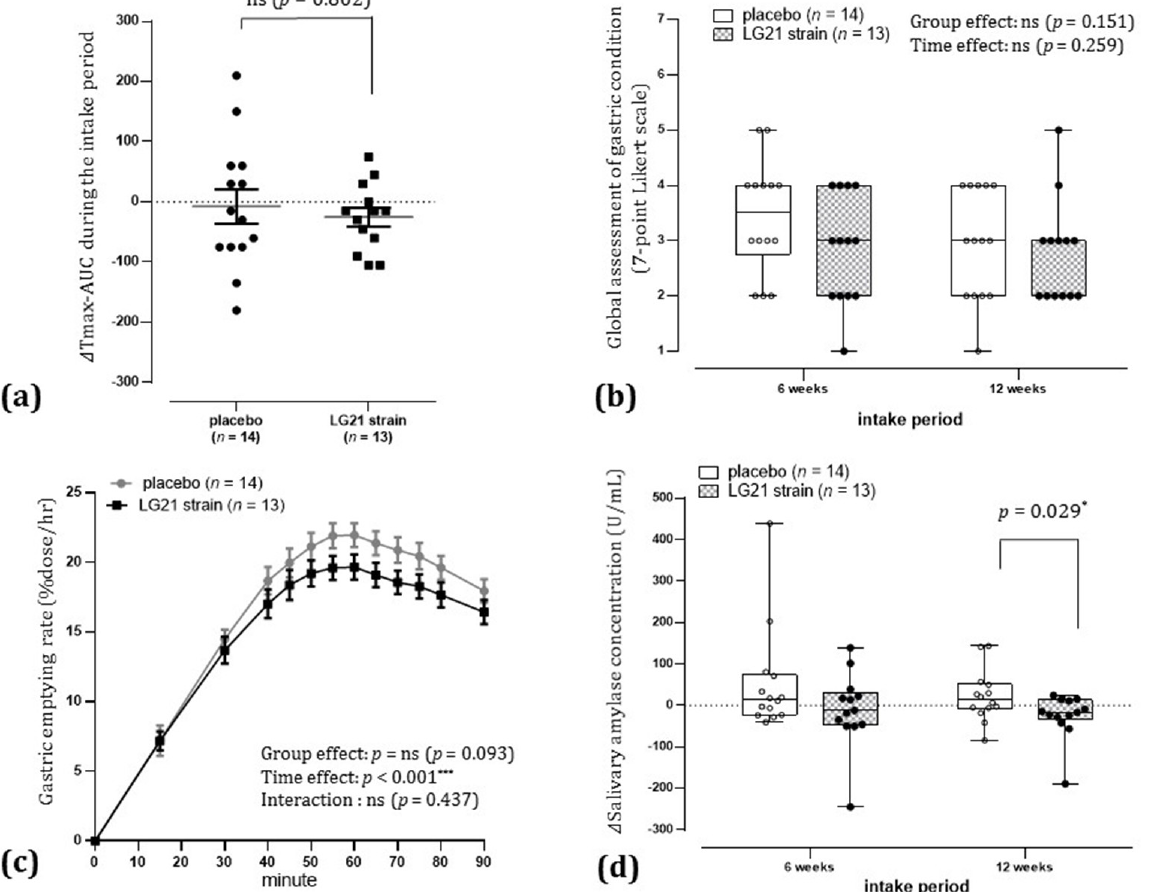
Figure 3. Effects of continuous intake of the LG21 strain in the per-protocol population. ( a ) ∆ Tmax-AUC during the intake period: The ∆ Tmax-AUC of each participant was obtained by plotting the origin, ∆ Tmax after 6 weeks of intake, and ∆ Tmax after 12 weeks of intake on a graph with intake time (weeks) on the x-axis and ∆ Tmax (minutes) on the y-axis, and connecting each plot with a straight line to calculate the AUC relative to baseline. The bars indicate the mean and standard error. Intergroup comparison was performed using the Wilcoxon rank-sum test (significance level, p < 0.05 [two-sided]). AUC, area under the curve; ns, not significant. ( b ) Global assessment of gastric condition: Participants’ impressions score of the overall effect on gastric condition were shown as dot plots and box plots (median, 25th to 75th percentile; bars show minimum and maximum). Data after 6 and 12 weeks of intake were tested for group effect and time effect using ordinal logistic regression analysis (significance level, p < 0.05 [two-sided]). ns, not significant. ( c ) Gastric emptying rate following ingestion of a liquid meal (after 12 weeks of intake): Gastric emptying rate is shown as mean and standard error. Group effect, time effect and interaction were tested using two-way repeated-measures analysis of variance (significance level, p < 0.05 [two-sided]; *** p < 0.001 [two-sided]). ns, not significant. ( d ) ∆ salivary amylase concentration: Changes in salivary amylase concentrations from baseline are shown as dot plots and box plots (median, 25th to 75th percentile; bars show minimum and maximum). Intergroup comparison was performed using the Wilcoxon rank-sum test (significance level, p < 0.05 [two-sided]); * p < 0.05